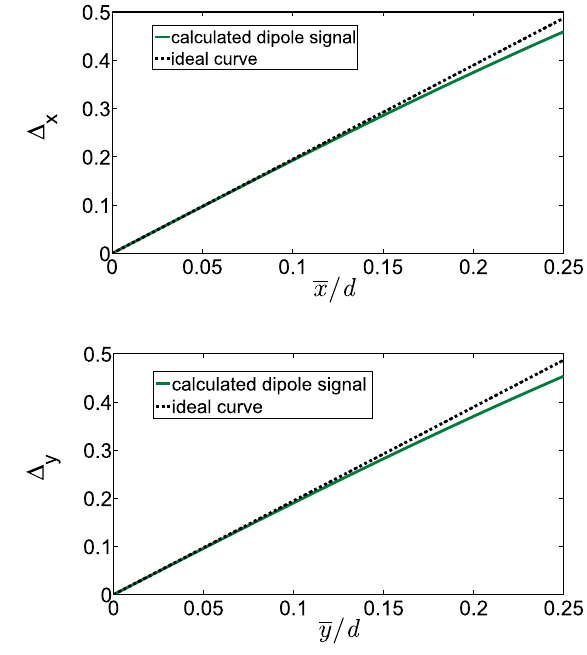
FIG. 4. Above: Δ x as a function of ¯ x=d , ¯ y=d ¼ 0 . 05 ; below: Δ y as a function of ¯ y=d , ¯ x=d ¼ 0 . 05